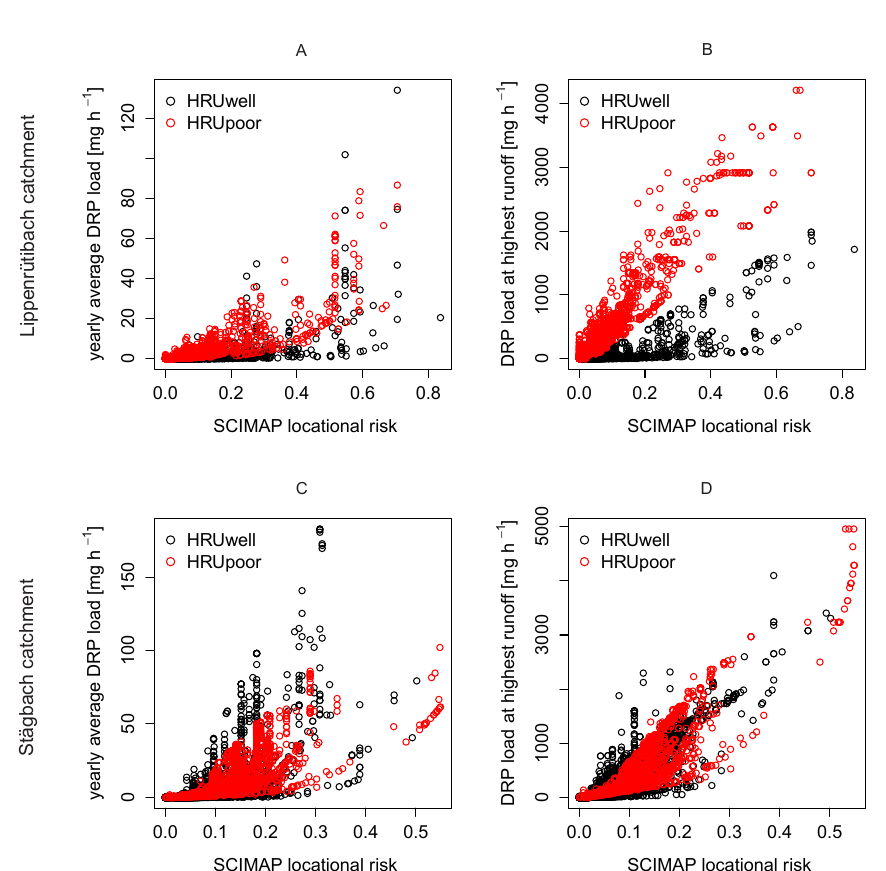
Figure 7. Comparison of the P load calculated with the RRP model, which differentiates between well-drained and poorly drained hydro- logical response units (HRU well , HRU poor ), for the entire monitoring period and the highest runoff event with the locational risk for P losses predicted using the SCIMAP